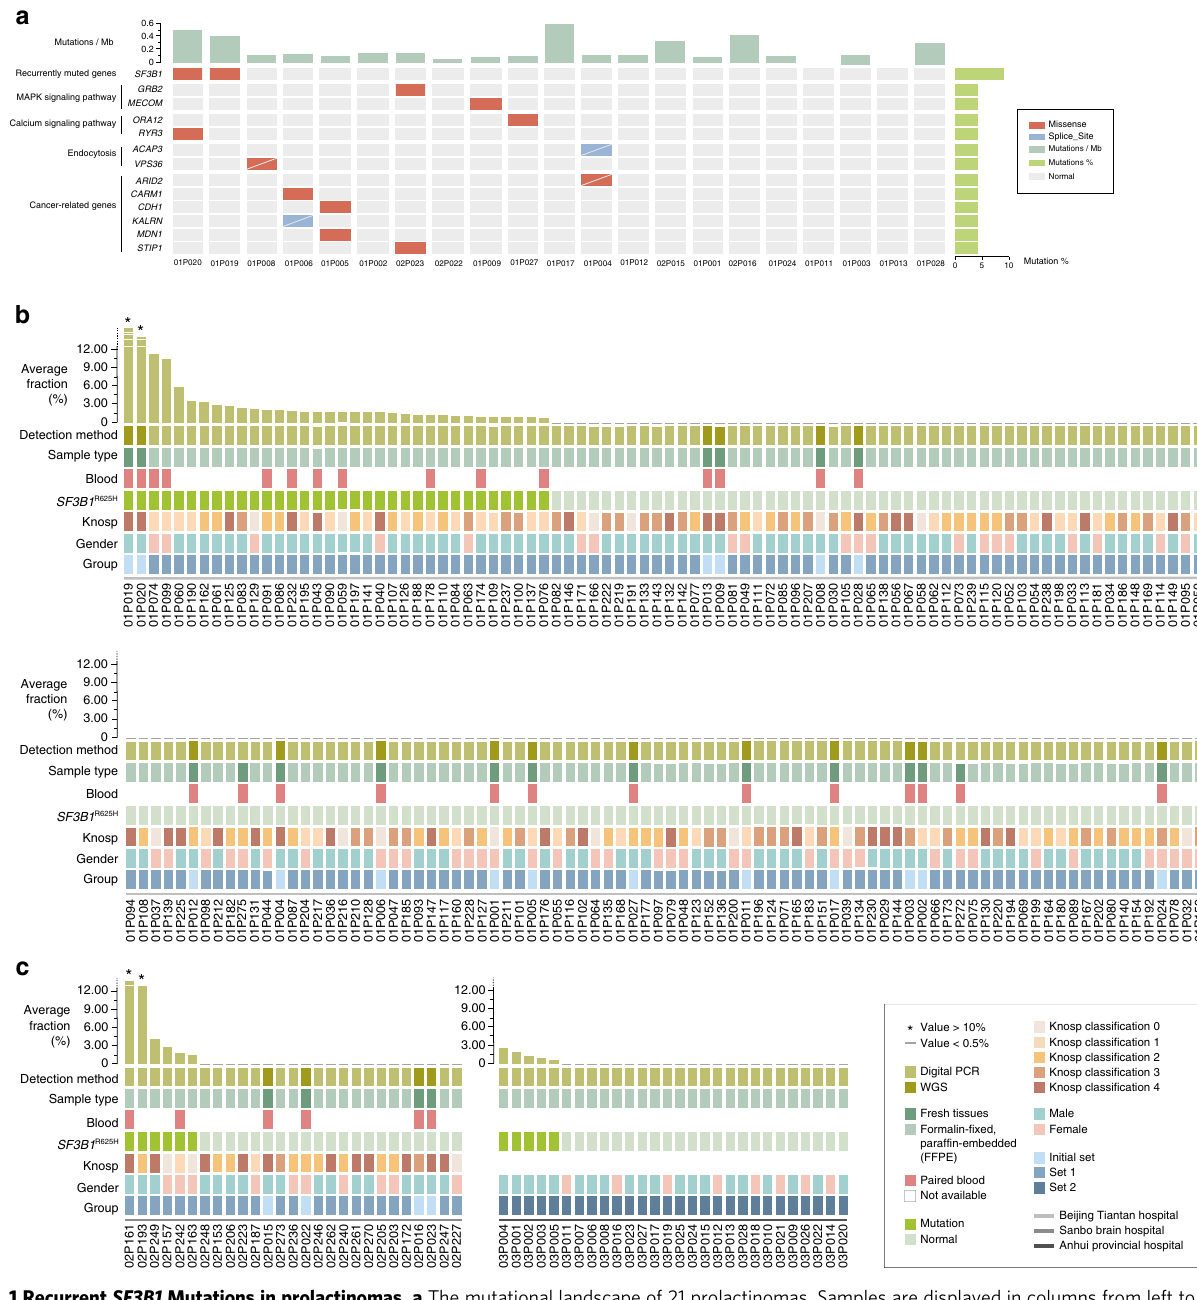
Fig. 1 Recurrent SF3B1 Mutations in prolactinomas. a The mutational landscape of 21 prolactinomas. Samples are displayed in columns from left to right. Each row represents a gene. The rates of synonymous and non-synonymous mutations are expressed in the number of mutations per megabase (Mb) and are displayed in the top panel. The somatic mutation frequencies for each candidate gene are plotted on the right panel. Mutations that were not validated through Sanger sequencing and time of fl ight mass spectrometer (TOF), because of an unsuccessful ampli fi cation or lack of remaining tissues, are represented by a white slash. Mutation types are color-coded as indicated above the image. All candidate genes are considered capable of expression with FPKM of over 1 in >20% of all RNA samples. b , c Detection of SF3B1 R625H mutations in the prolactinoma tumor samples. The top chart shows the fractional abundance of variants on micro fl uidic-chamber-based digital PCR analysis in prolactinoma tissue samples. The samples are shown according to the order of highest to lowest frequency, b the section 1 included 172 patients from Beijing Tiantan Hospital af fi liated to Capital Medical University, c the section 2 included 27 patients from Sanbo Brain Hospital and section 3 included 28 patients from the First Af fi liated Hospital of University of Science and Technology of China. At the bottom of the chart shows the details of the sample, including the detection method, the sample type, the presence or absence of a paired blood sample, SF3B1 R625H mutation detected, the Knosp classi fi cation, gender and group. Source data are provided as a Source Data fi Fig. 6a). These genes all showed upstream cryptic 3 ′ splice sites splice sites (A3SS), 2 alternative 5 ′ splice sites (A5SS), 22 mutually with the cryptic AG site located between 16 and 25 nucleotides exclusive exons, 36 skipped exons, and 17 retained introns. A upstream of the canonical site (Supplementary Fig. 6b). These data signi fi cant overrepresentation of regulated A3SS was found in the re fl ect the importance of structural similarity in recognizing the comparison of SF3B1 R625H with wild-type tumors (Supplementary